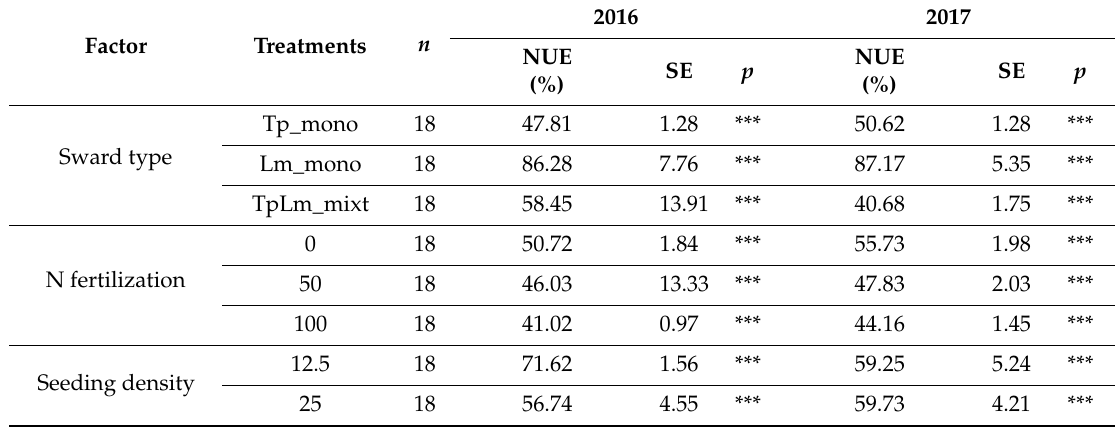
Table 6. N use e ffi ciency in monoculture and